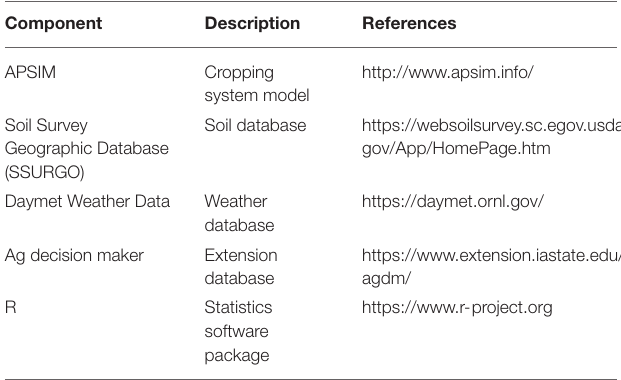
TABLE 1 | Framework components and data